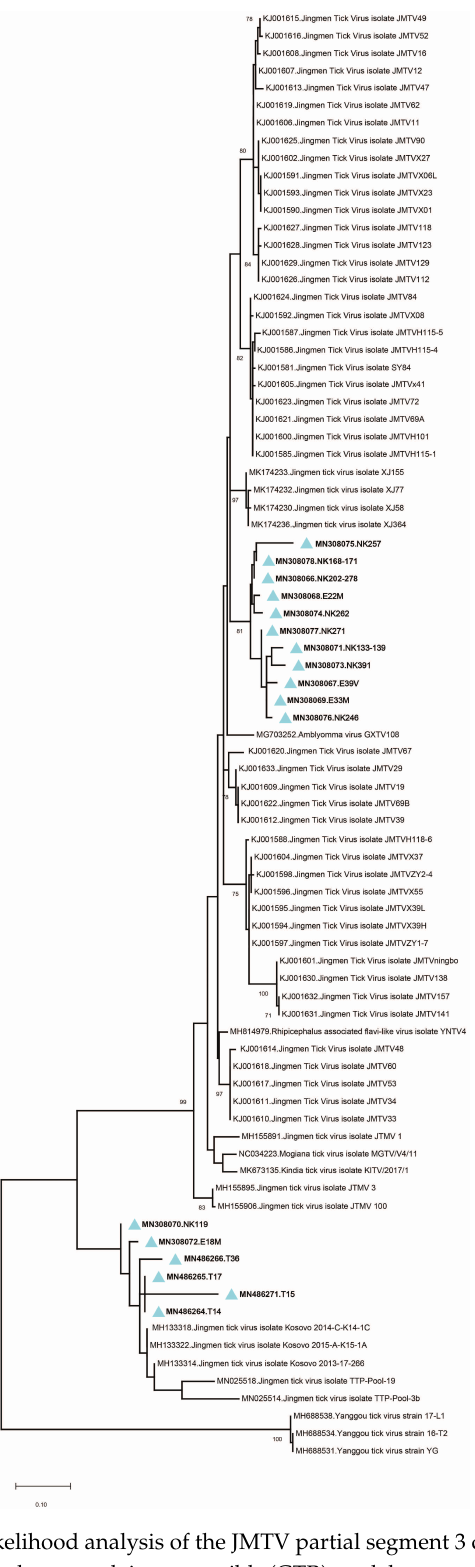
Figure 2. Retinal ganglion cell topography in intact retinas. Neighbour map illustrating the topography Figure 2. The maximum likelihood analysis of the JMTV partial segment 3 coding sequences (253 bp). of RGCs in a representative intact retina. Neighbour maps illustrate the number of RGCs around a The tree is constructed using the general time reversible (GTR) model, gamma distributed with invariant given RGC in a radius of 0.200 mm with a colour scale (bottom right) from 0–25 neighbours (purple) to sites (G + I) for 500 replications. The sequences characterized in this study are given in bold and > 201 neighbours (dark red). The bottom left of the map shows the number of RGCs counted in the indicated with a blue triangle, GenBank accession number and specimen codes. Global virus strains original retina. S: superior; N: nasal. are indicated by GenBank accession number, virus and strain / isolate name. Bootstrap values higher than 70 are